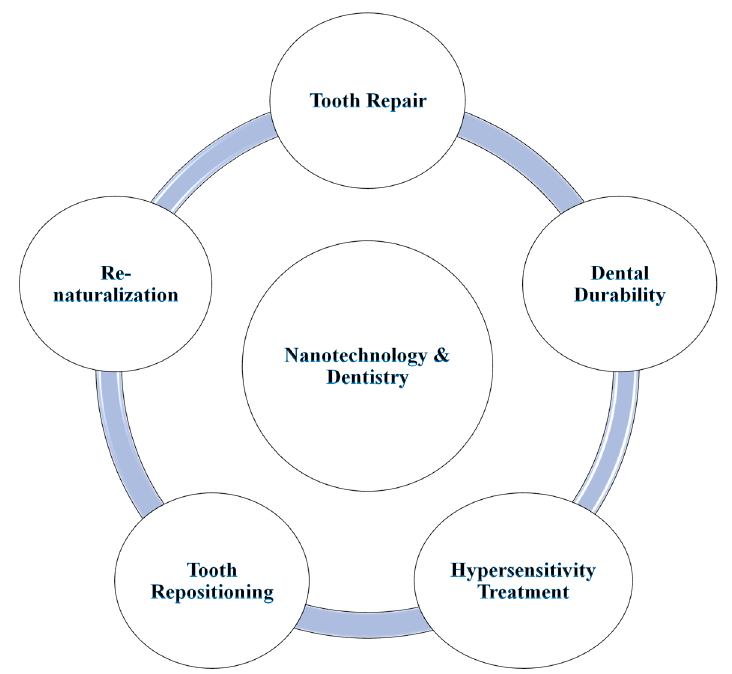
Figure 3. Nanotechnology applications in field of dentistry. Nanotechnology can be largely used in dentistry to repair and treat dental issues.